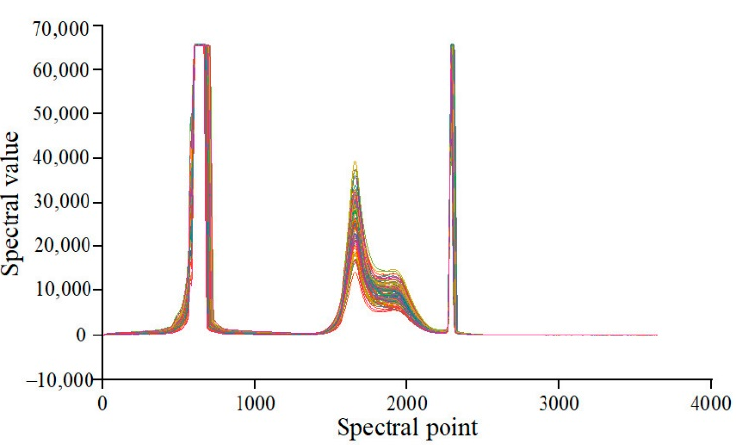
Figure 2. Fluorescence spectral value of tomato leaves.